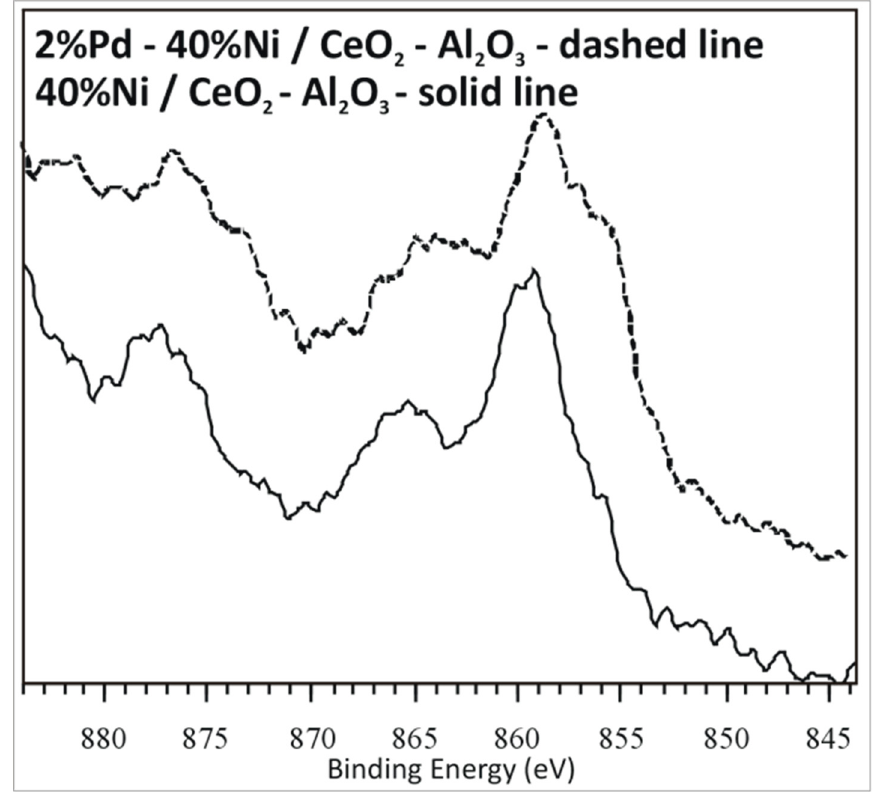
Figure 11. Ni 2p X-ray photoelectron spectroscopy (XPS) spectra of 40%Ni/CeO 2 –Al 2 O 3 and 2%Pd–